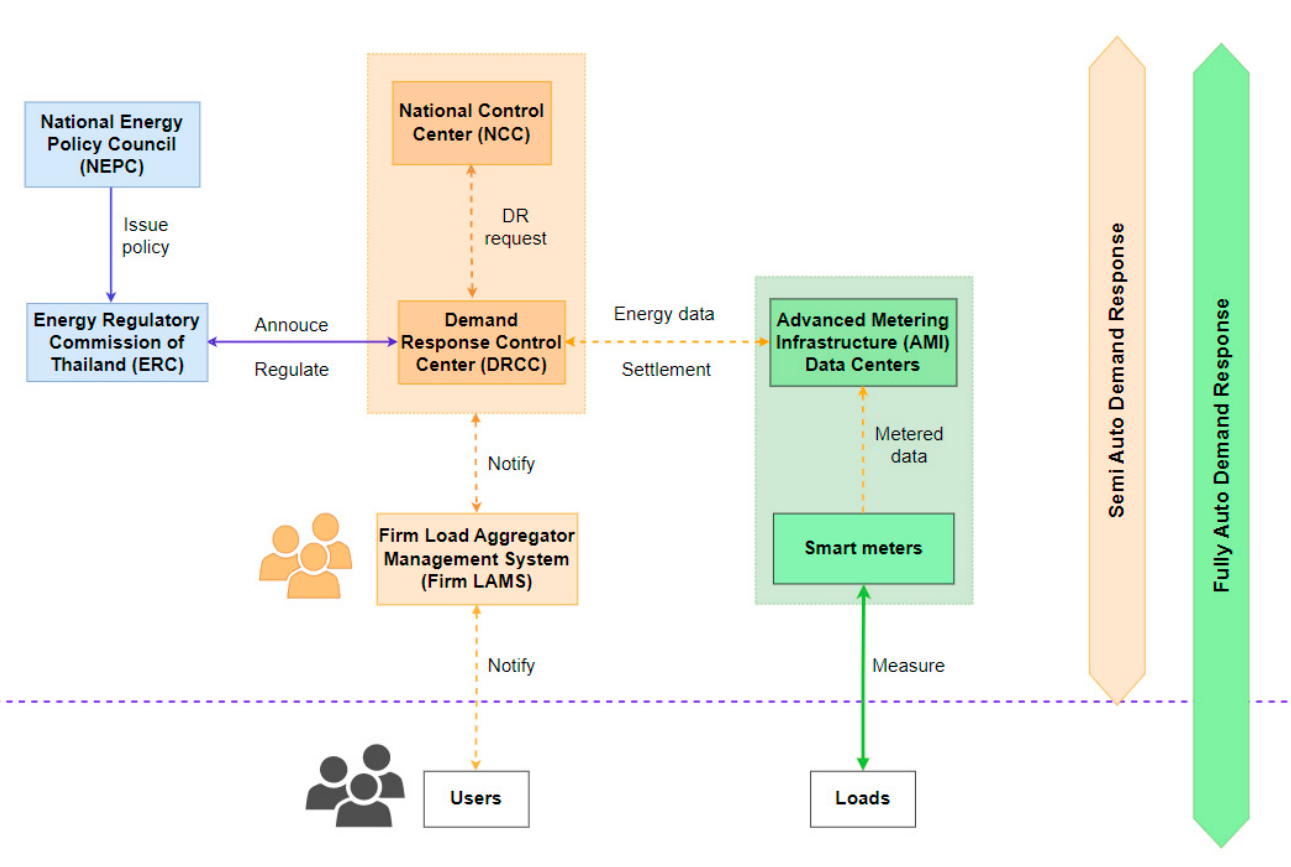
Figure 1. The current demand response model in Thailand.